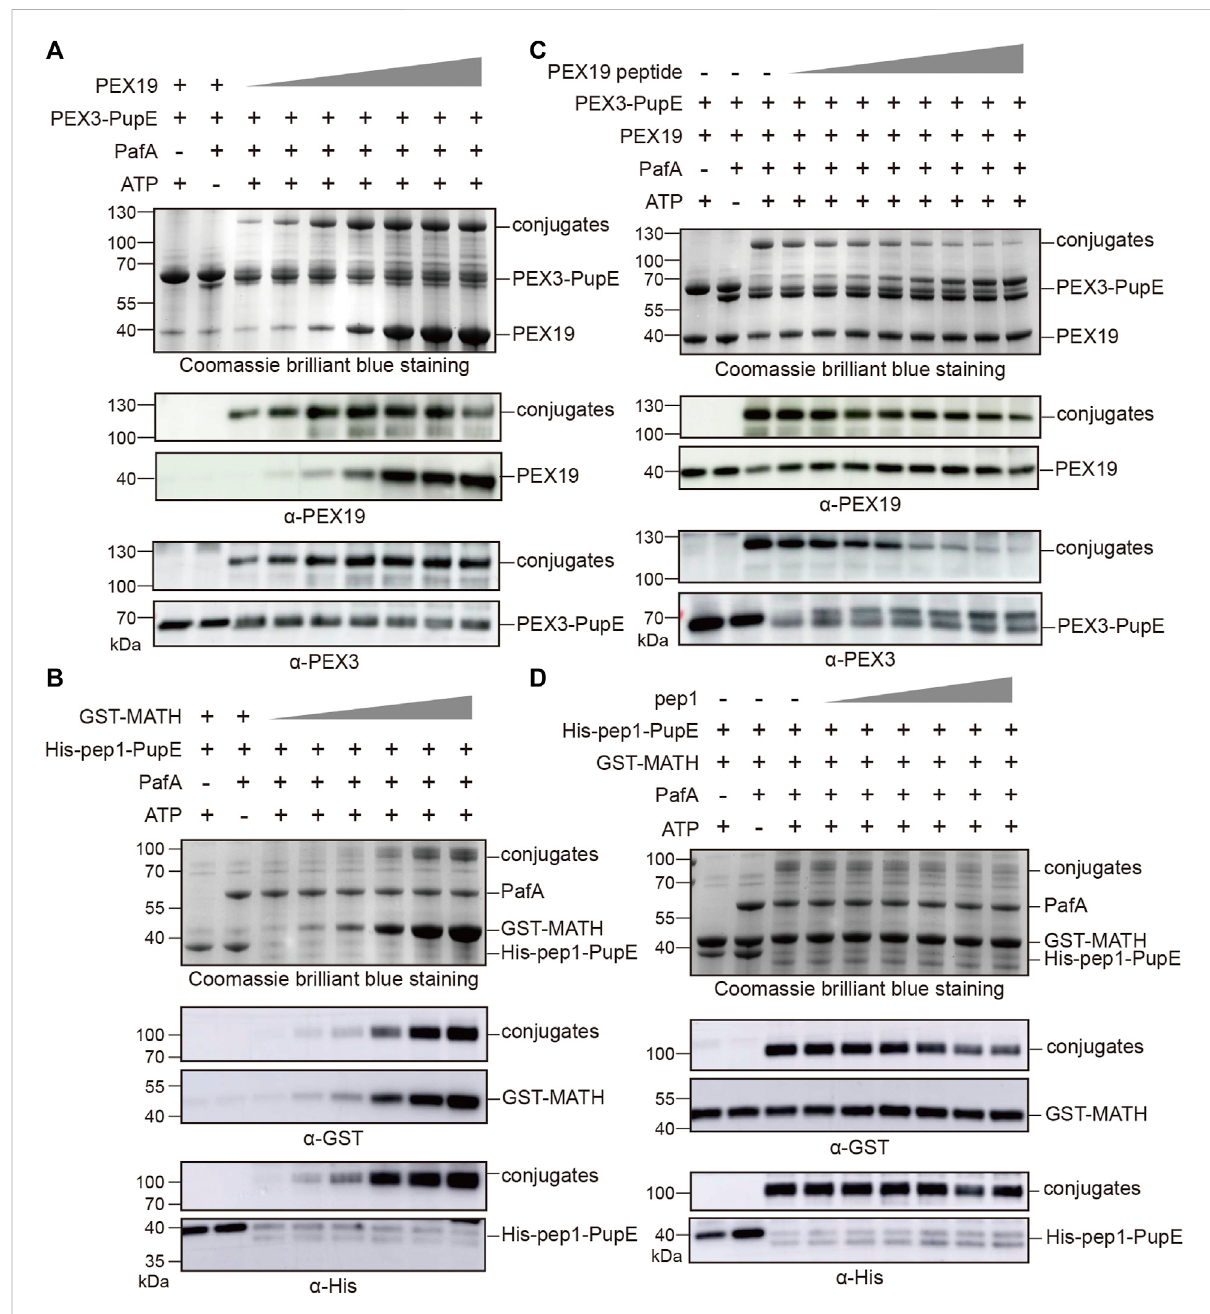
FIGURE 2 PUP-IT2systemlabelsspeci fi cinteractingproteins.Coomassiestainandwesternblottingtoexaminetheformationofproteinconjugates. (A) In thePUP-IT2 PEX3 invitro reactionsystem,PEX19wasaddedattheconcentrationsfrom1.25 µMto30 µM(1.25,2.5,5,10,20,25,and30 µM). (B) Inthe PUP-IT2 pep1 in vitro reaction system, GST-MATH was added at the concentrations from 1.25 µM to 40 µM (1.25, 2.5, 5, 10, 20, and 40 µM). (C) Free PEX19 peptide was dosed in to the PUP-IT2 PEX3 in vitro reactions containing 10 µM PEX3-PupE, and PEX19 peptide concentrations varied from 20 μ M to 2.5 mM (20, 40, 80, 160, 320, 640, 1300, 2500 µM). (D) Free pep1 peptide was dosed in to the PUP-IT2 pep1 in vitro reactions containing 10 µM His-pep1-PupE, and pep1 peptide concentrations varied from 20 μ M to 0.48 mM (20, 40, 80, 160, 320, and 480